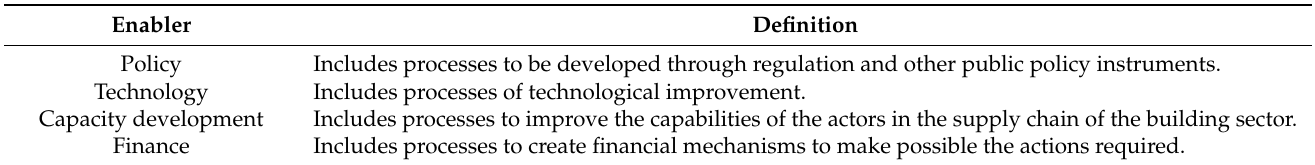
Table 2. Definition of enablers in the Colombian Net-Zero Carbon Buildings Roadmap.